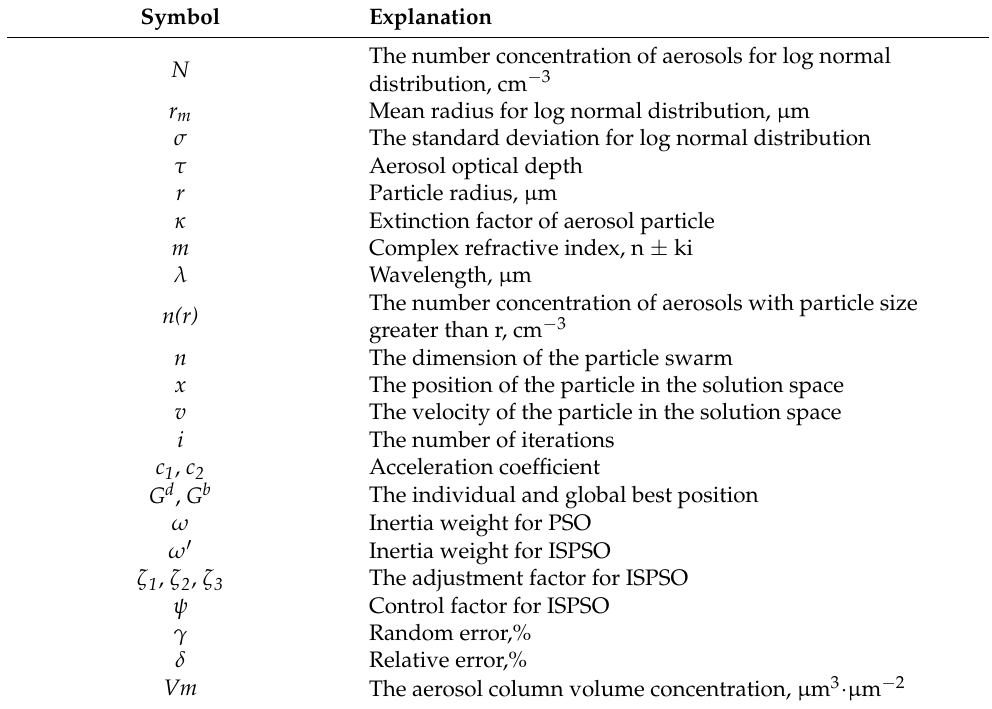
Table 1. Symbol, nomenclature, and